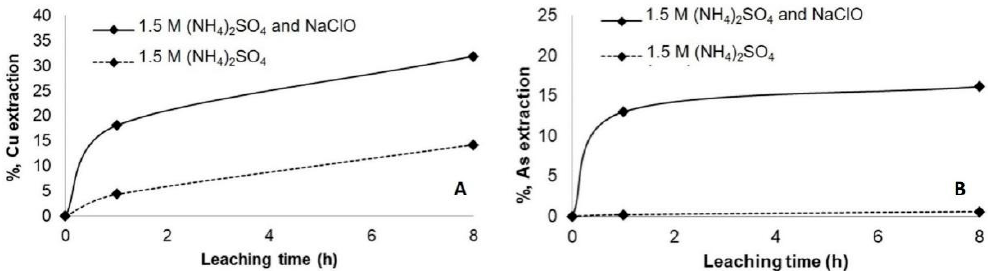
Figure 7. Copper ( A ) and arsenic ( B ) extraction at ambient condition using 1.5 M of (NH 4 ) 2 SO 4 with and without the addition of 10 g/L NaClO.